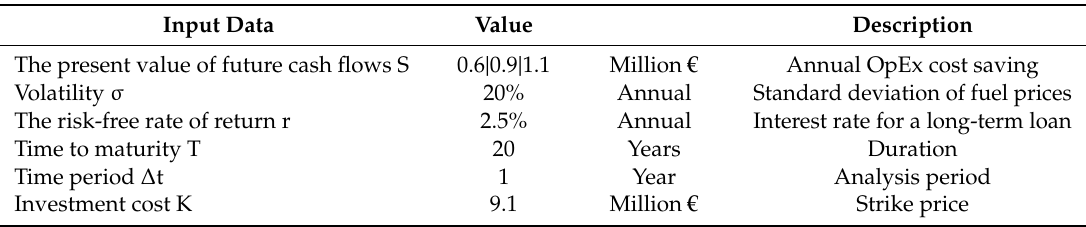
Table 8. First Year Real-Option Data for the three